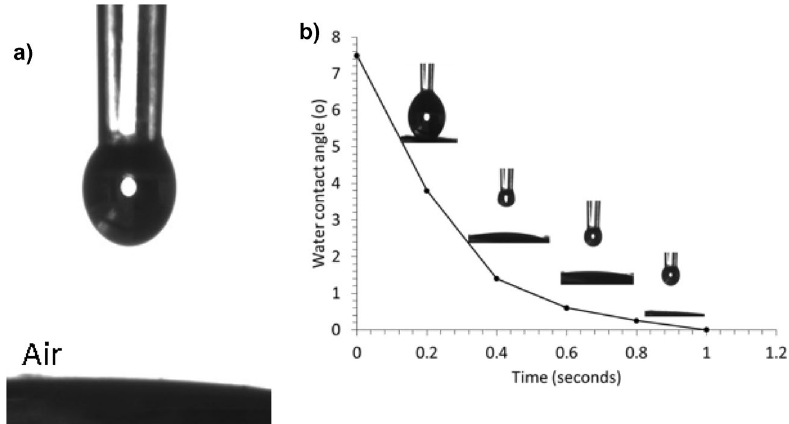
Figure 6. Water contact angle measurement of the MnO 2 coated carbon microfiber using a sessile drop method. ( a ) Water contact angle of the MnO 2 coated on the carbon microfibers. (0°) and ( b ) dynamic water contact angles: water droplet behaviour when water drops on the carbon microfibers coated with MnO 2 nanosheets. Water contact angle measurement for pristine carbon microfiber can be found in Figure S4 of the supporting